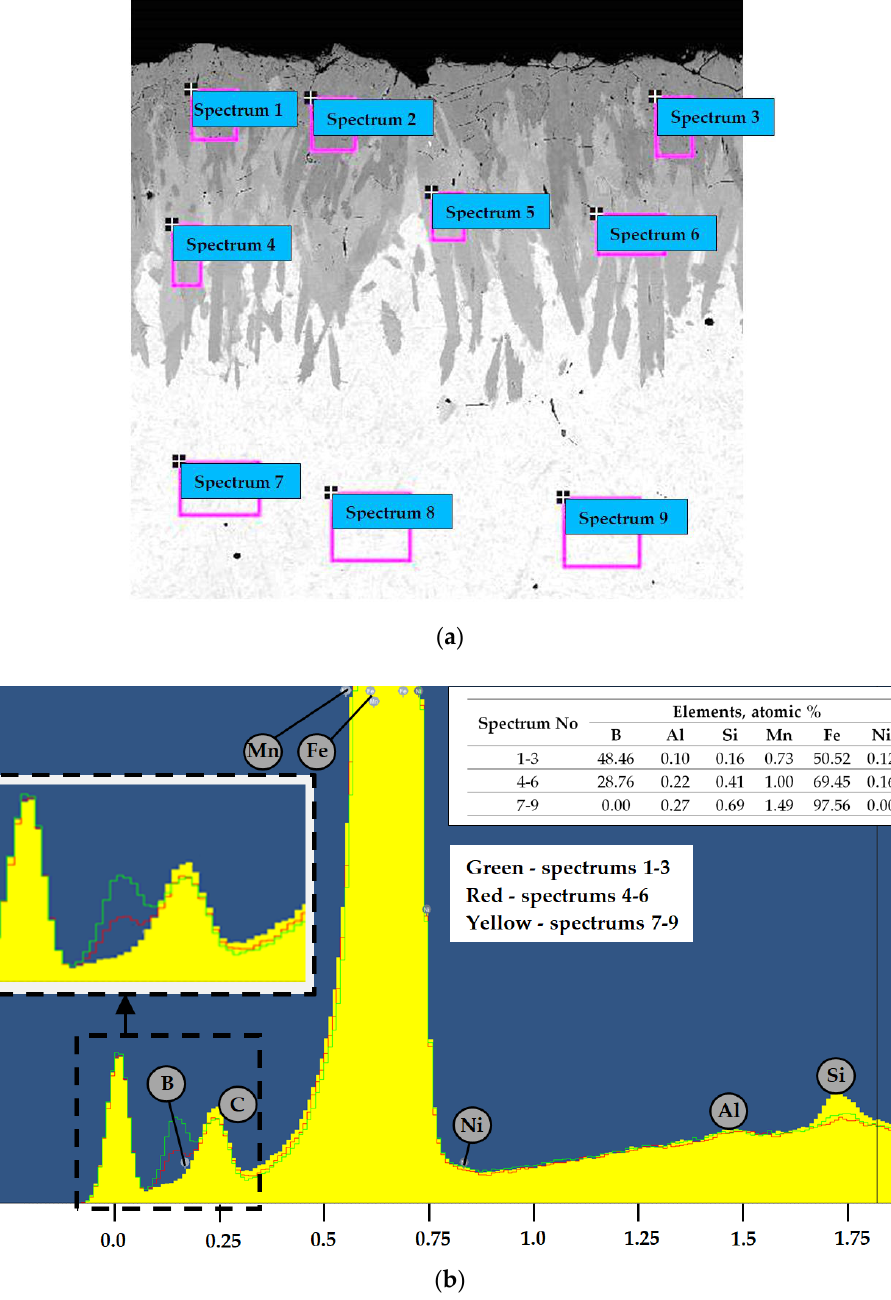
Figure 3. Analysis of the elemental composition of the boride layers: ( a ) map of analysis of elemental composition; ( b ) SEM elemental map.